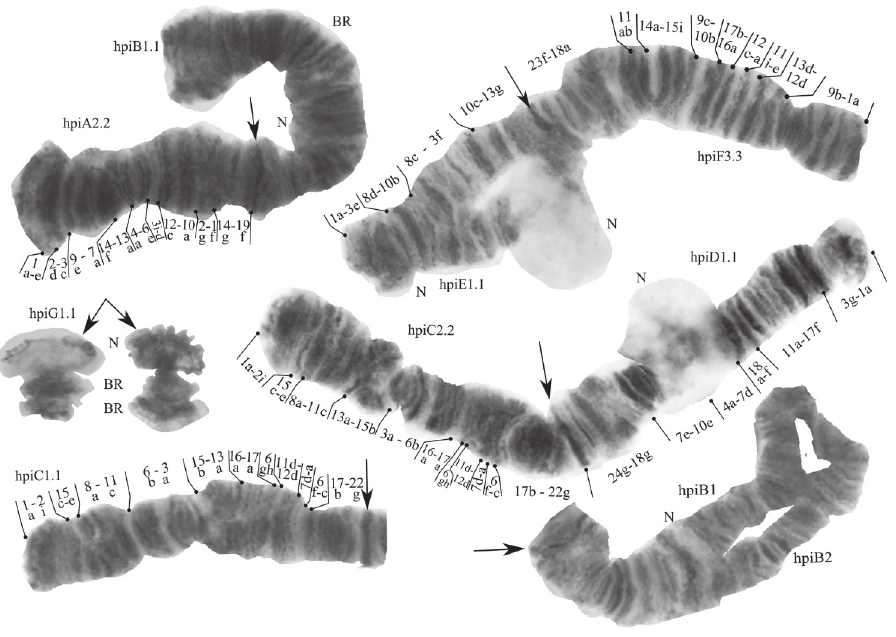
Figure 3. Karyotype of Chironomus heteropilicornis from the Gydan Peninsula, Russia. Arrows indicate centromeric band, hpiA2.2, hpiB1.1 and etc. – genotypic combinations of banding sequences in chromo- some arms, BR – Balbiani rings, N –